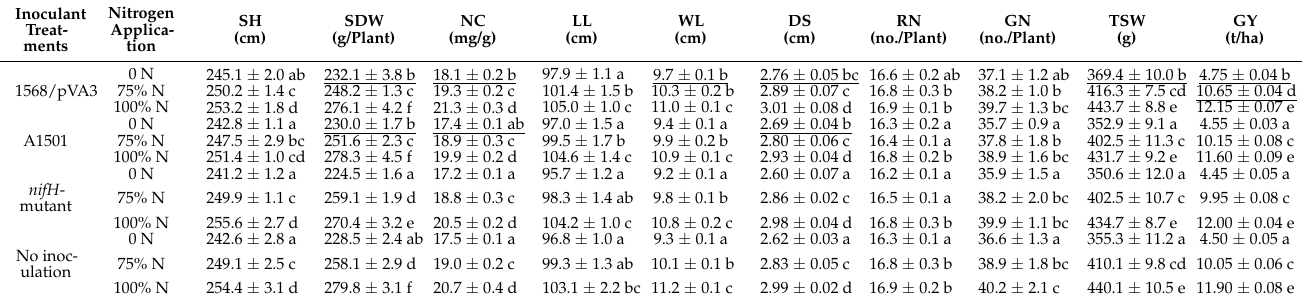
Table 5. Shoot height (SH), shoot dry weight (SDW), shoot N concentrations (NC), length (LL) and width (WL) of leaf, diameter of shoot (DS), the row numbers per ear (RN) and grain numbers per row (GN), thousand seed weight (TSW) and grain yield (GY) of maize plants from the field experiment. 0 N, 0 kg of N ha − 1 ; 75% N, 75 kg of N ha − 1 ; 100% N, 100 kg of N ha − 1 . The values are mean ± standard deviations (n = 20). Different letters (a–f) indicate a significant difference ( p < 0.05) according to ANOVA